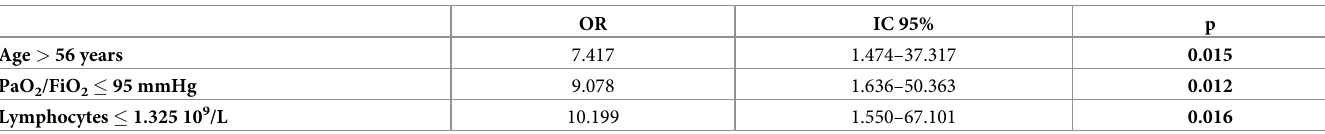
Table 5. Multivariate logistic